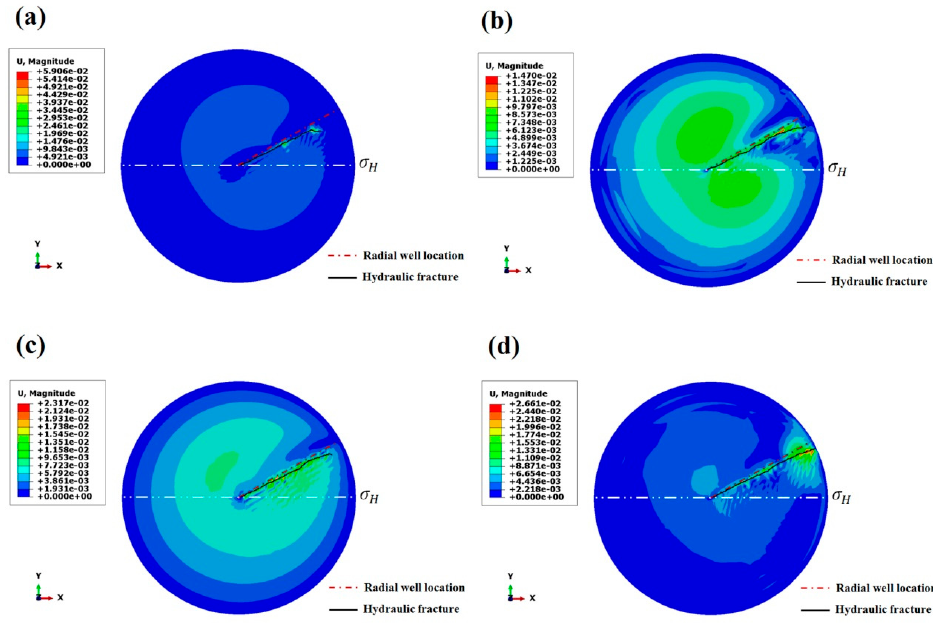
Figure 14. Simulation results of hydraulic fracture propagation guided by the single radial well under the different fracturing fluid injection rates: ( a ) 1 m 3 /min; ( b ) 3 m 3 /min; ( c ) 6 m 3 /min; and ( d ) 9 m 3 /min.